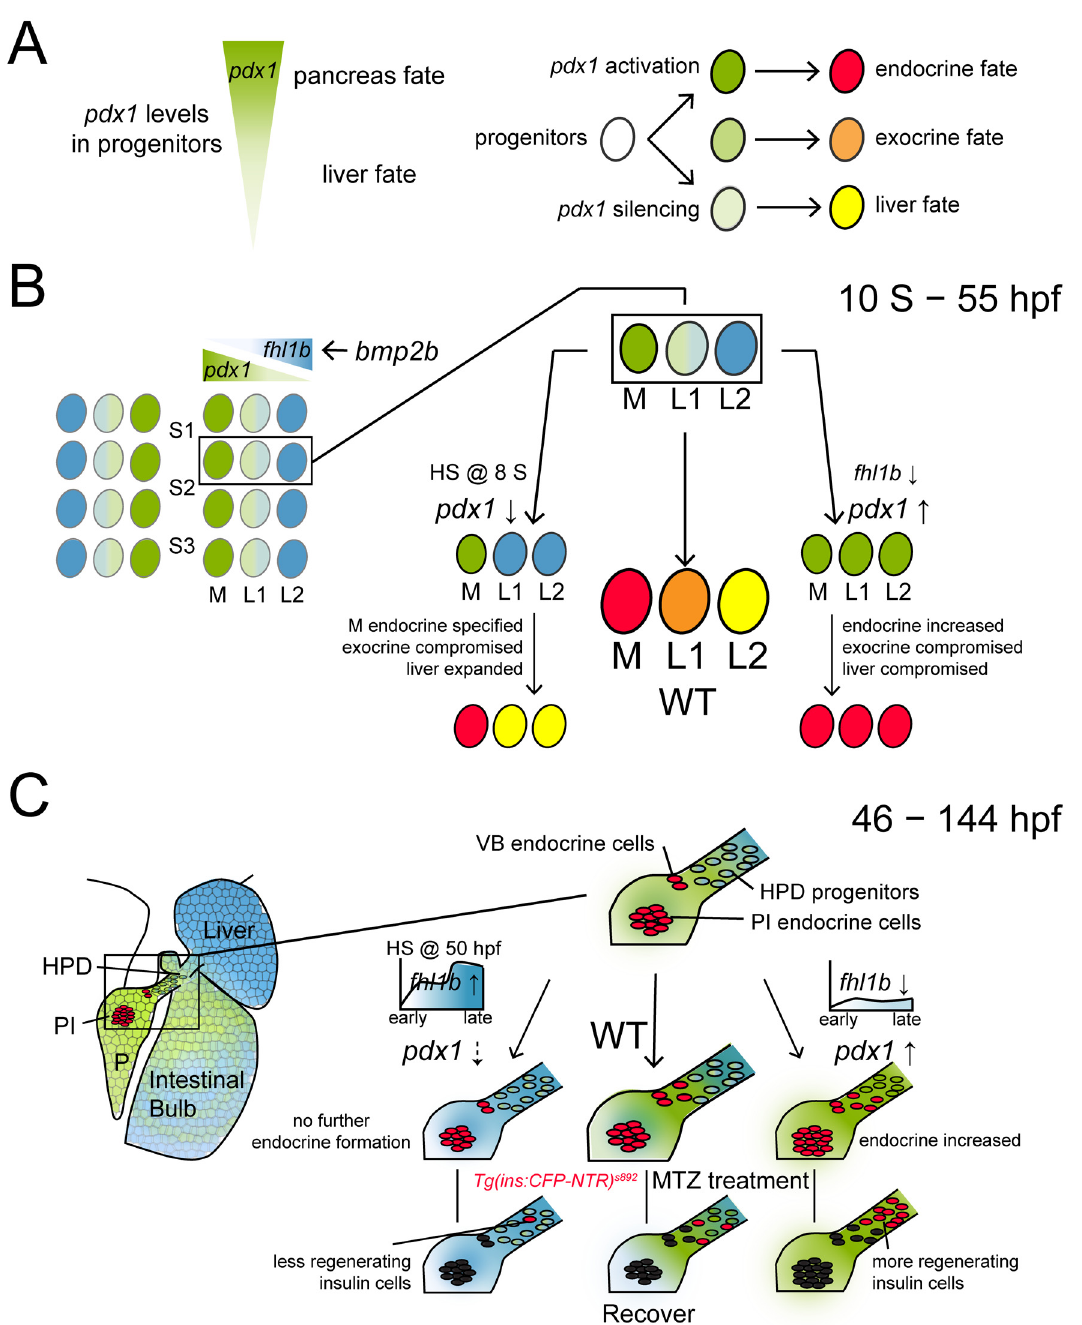
Fig 7. Fhl1b is essential for regulating the cell fate choice of liver versus pancreas and for β -cell regeneration. Schematic model for the role of Fhl1b in lineage specification and in β -cell regeneration. The expression of fhl1b and pdx1 is color-coded as blue and green, respectively. (A) Endodermal progenitors experience different levels of pdx1 regulating their fates as pancreatic endocrine (high levels of pdx1 ), pancreatic exocrine (low levels of pdx1 ), or liver ( pdx1 silencing) cells. (B) From the 12-somite stage onwards, single endodermal cells in the lateral 2 position (L2) between somites 1 and 3 in the endodermal sheet give rise not only to pancreatic exocrine cells and intestinal cells, but also to liver cells, functioning as bipotential hepatopancreatic progenitors. bmp2b , which is expressed in the lateral plate mesoderm, induces fhl1b expression in the prospective liver anlage. This may form a reciprocal gradient of fhl1b - pdx1 . Decreased Fhl1b function leads to an increase in levels of pdx1 expression in lateral 1 and 2 cells, causing a hepatic and pancreatic exocrine to a pancreatic endocrine fate switch. Conversely, augmentation of Fhl1b activity at the initial time point of pdx1 expression in the pancreatic exocrine and intestinal progenitors (HS @ 8 S) causes a decrease in levels of pdx1 expression in pancreatic exocrine and intestinal progenitor cells, leading them to become liver cells. The lineage of the most medial cells, which express high levels of pdx1 and subsequently give rise to pancreatic endocrine cells,